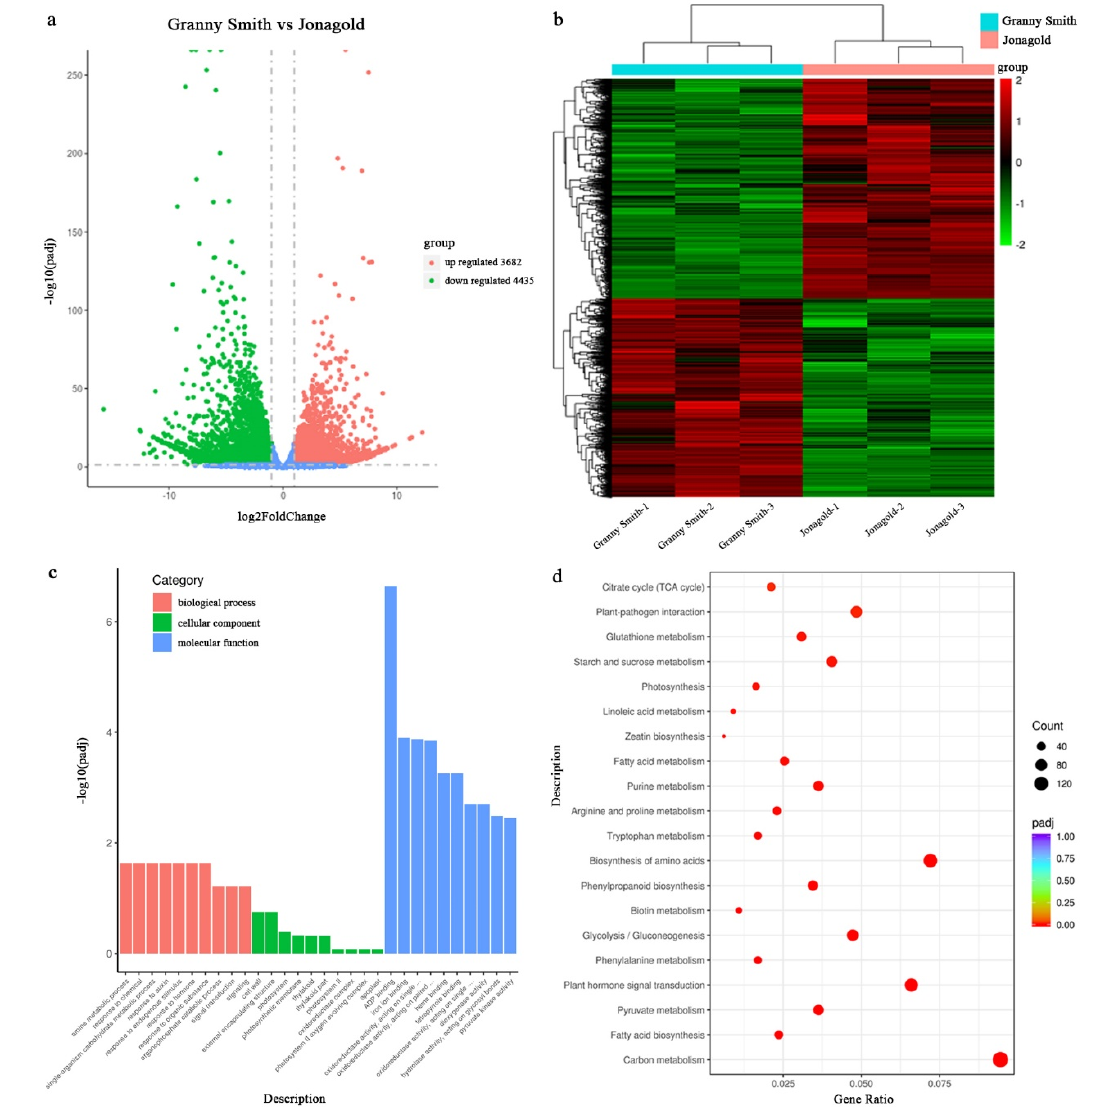
Figure 3. Analysis of differentially expressed genes (DEGs) between Granny Smith and Jonagold apples. ( a ) Volcano plot of DEGs. ( b ) Hierarchical cluster analysis of DEGs. ( c ) Gene ontology (GO) classifications of DEGs. ( d ) Kyoto Encyclopedia of Genes and Genomes (KEGG) pathway enrichment of DEGs.